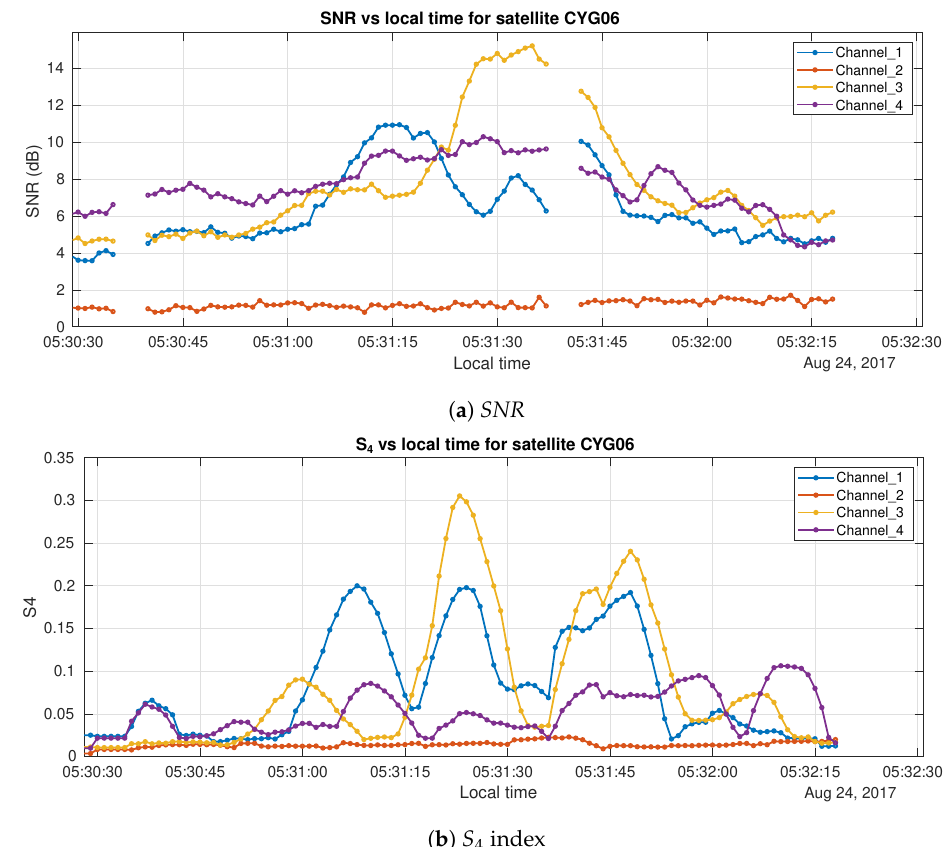
Figure 12. SNR and S 4 values plotted against LT for western peak in Figure 11 during 24 August 2017, for the four channels of one of CYGNSS satellites. Note that the S 4 rises with the transitions of SNR. For channel 3, it appears 2 peaks of S 4 , one before and one after the SNR peak, and the same happens for channel